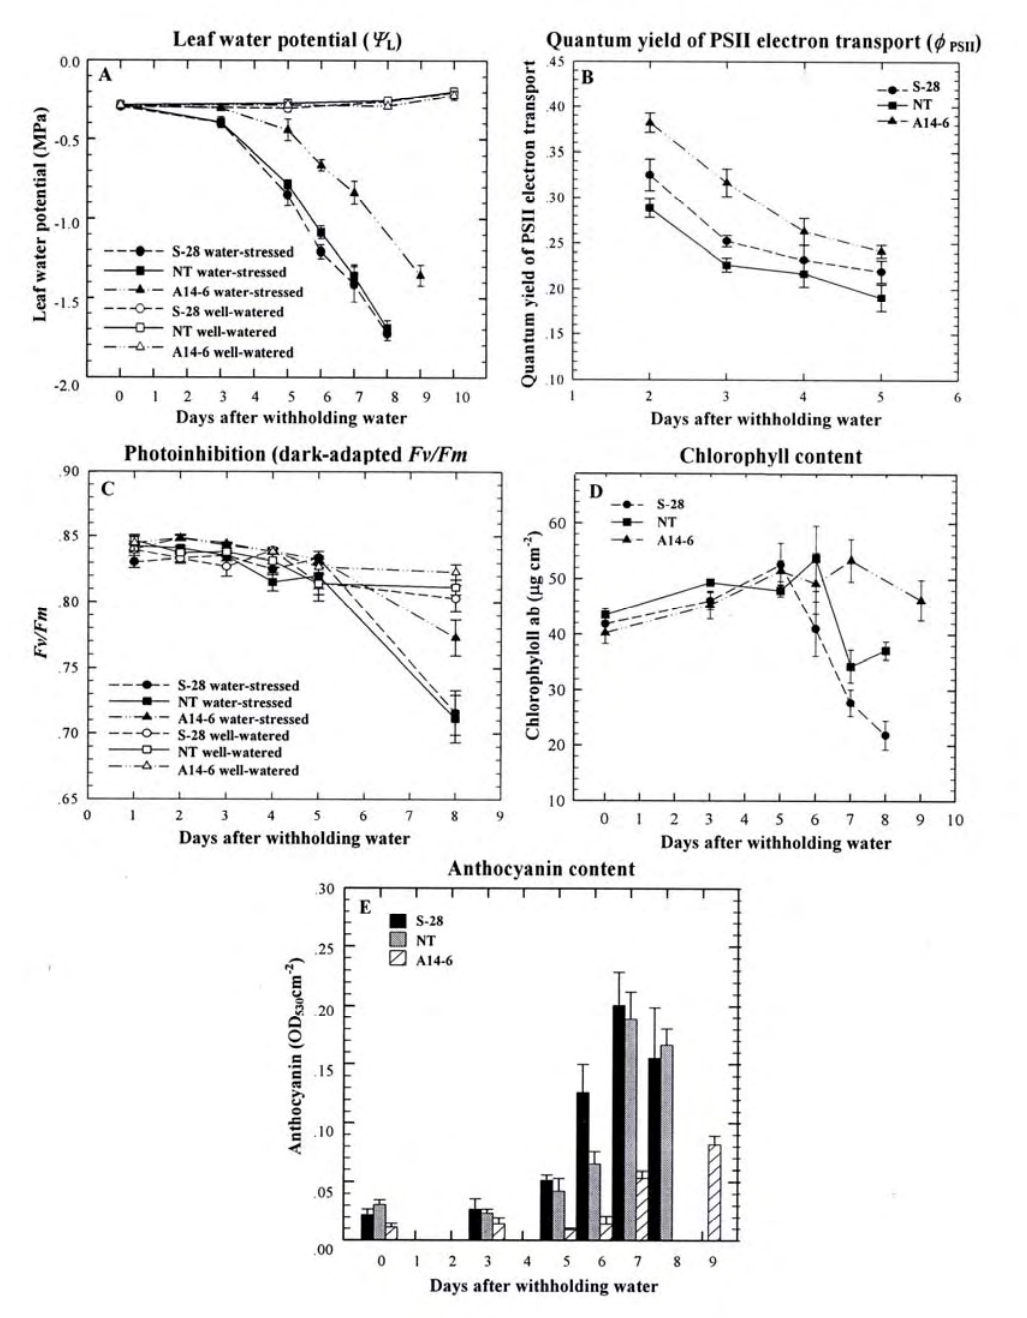
Figure 4. Leaf water potential ( Ψ ) during water stress declines more slowly in L transgenic plants with suppressed PPO levels (A). During water stress these plants exhibits higher quantum yields of PSII electron transport ( φ ; B) but lower PSII photoinhibition (C) compared to nontransformed controls. Suppression of PPO reduces chlorophyll loss (D) and anthocyanin accumulation (E) in leaflets at node 7. Results are presented as means ± SE